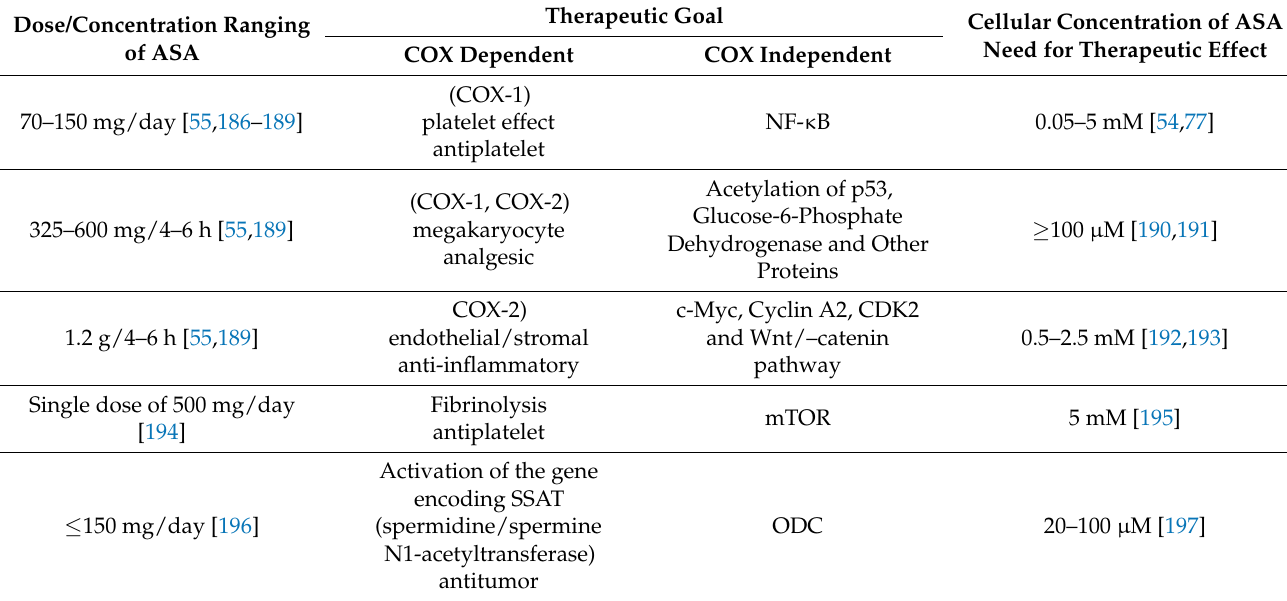
Table 3. ASA dosage dependent action on various therapeutic